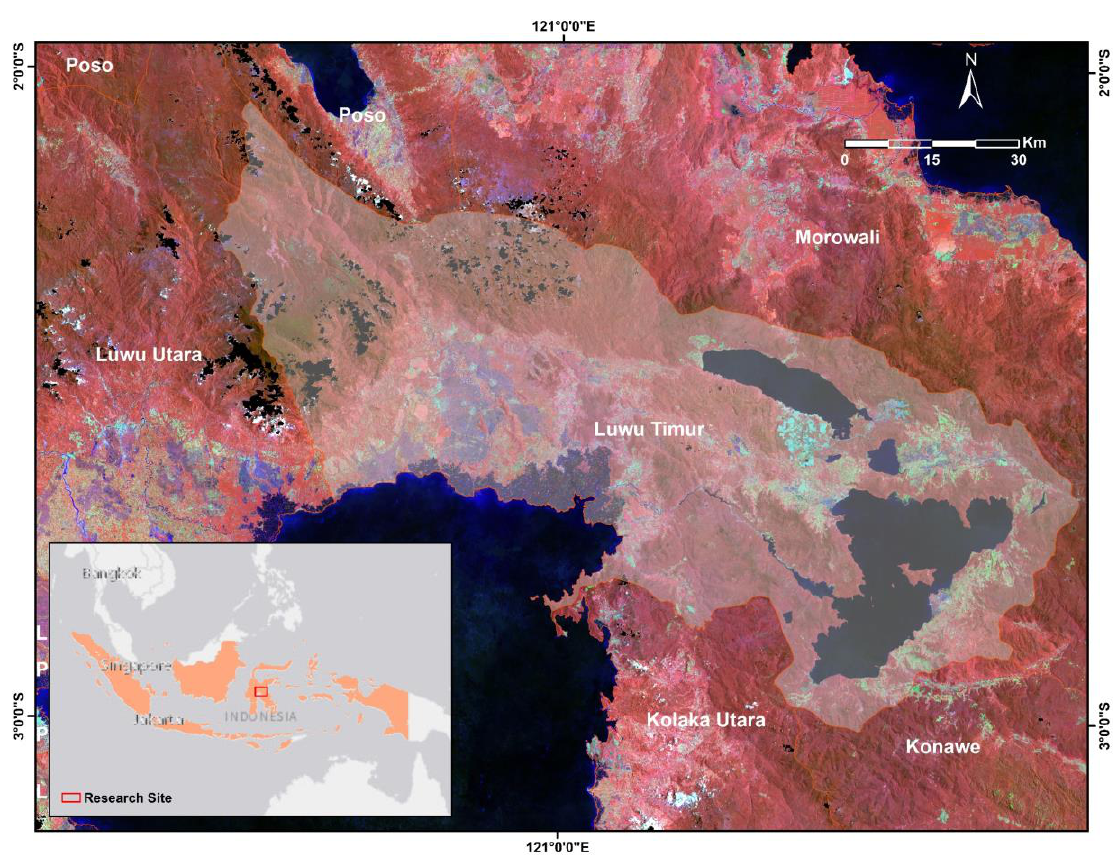
Figure 1. Study area for this research located in the East Luwu (Luwu Timur), Indonesia.